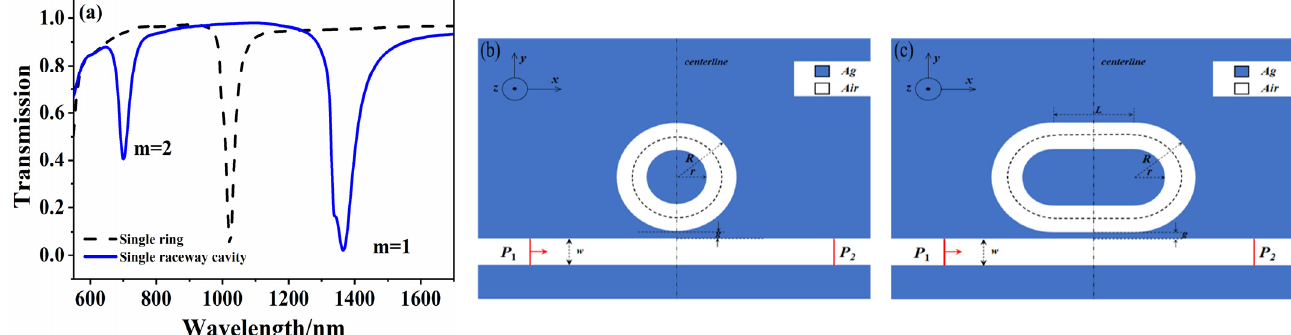
Figure 2. Comparison of transmittance spectrum between a circular ring and a RTRC side-coupled to a bus waveguide ( a ) Transmission pattern. ( b ) Schematic diagram of the structure of the ring. ( c ) schematic diagram of the structure of the raceway cavity.